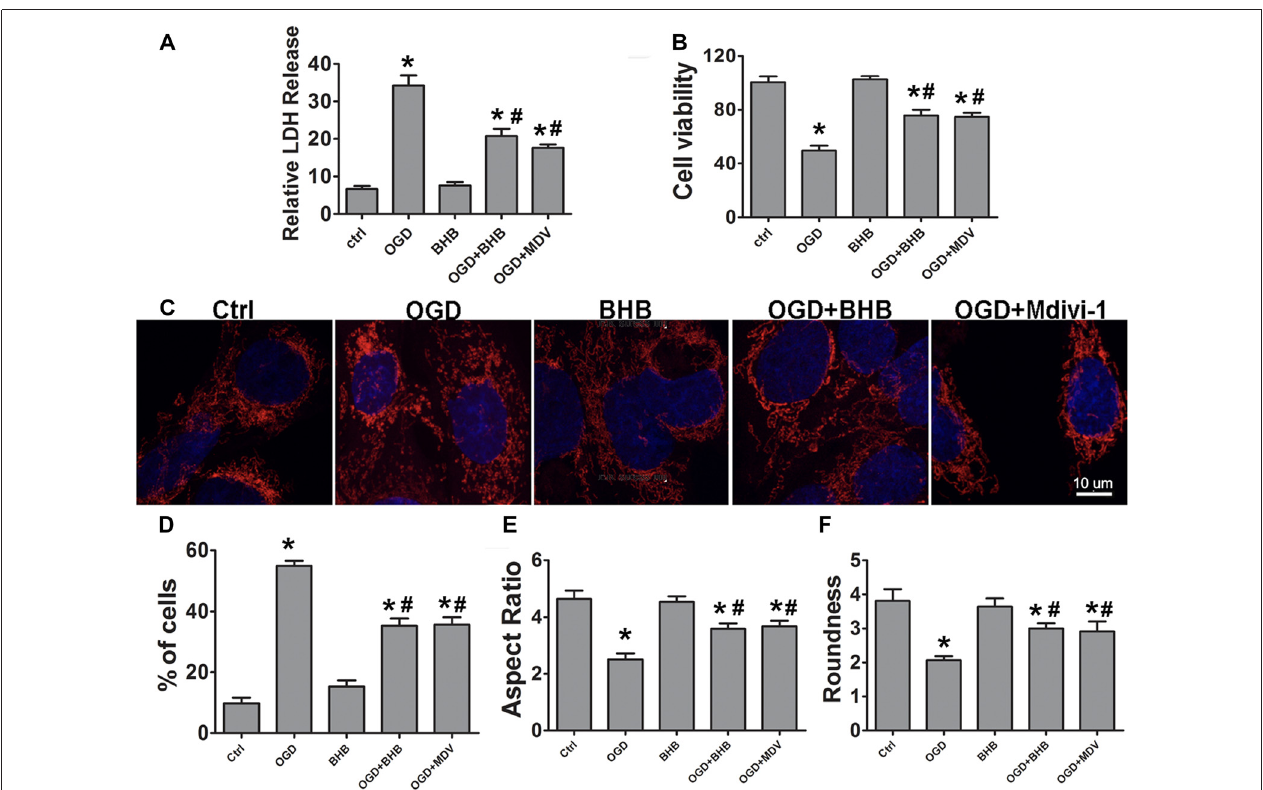
FIGURE 4 | β -hydroxybutyrate (BHB) and mdivi-1 influenced cell survival and mitochondrial morphology in response to oxygen–glucose deprivation/reoxygenation (OGD/R) damage. BHB and mdivi-1 treatment inhibited lactate dehydrogenase (LDH) release (A) and improved cell viability (B) after OGD/R. Data were from six independent experiments. (C) Cultured SH-SY-5Y cells were labeled with MitoDs-red for the evaluation of mitochondrial morphology. Scale bar: 10 µ m (D) Percentage of cells with truncated or fragmented mitochondria. Quantification was performed in a blind manner from more than 200 cells in at least 10 randomly selected fields at 200 × from three independent experiments. (E,F) Quantification of mitochondrial morphology. Roundness was calculated as perimeter 2 /4 π area. Aspect ratio is a measurement of major/minor axes. Both of these values approach 1 as the particle becomes more circular. Quantification was performed from 10 to 15 randomly selected cells in three independent experiments. Data are shown as mean ± SEM; ∗ P < 0.01 vs. Ctrl group, # P < 0.05 vs. OGD